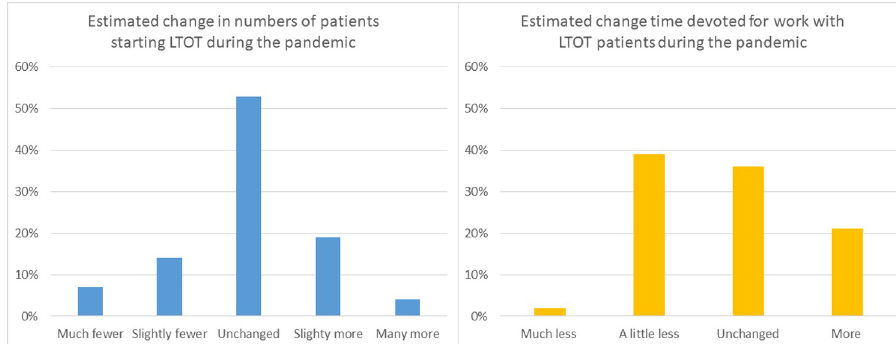
Fig 3. Change in LTOT incidence and working time with LTOT during the pandemic. Estimated impact of the covid-19 pandemic on LTOT starts and work in Sweden. Abbreviations : LTOT = Long Term Oxygen Therapy .